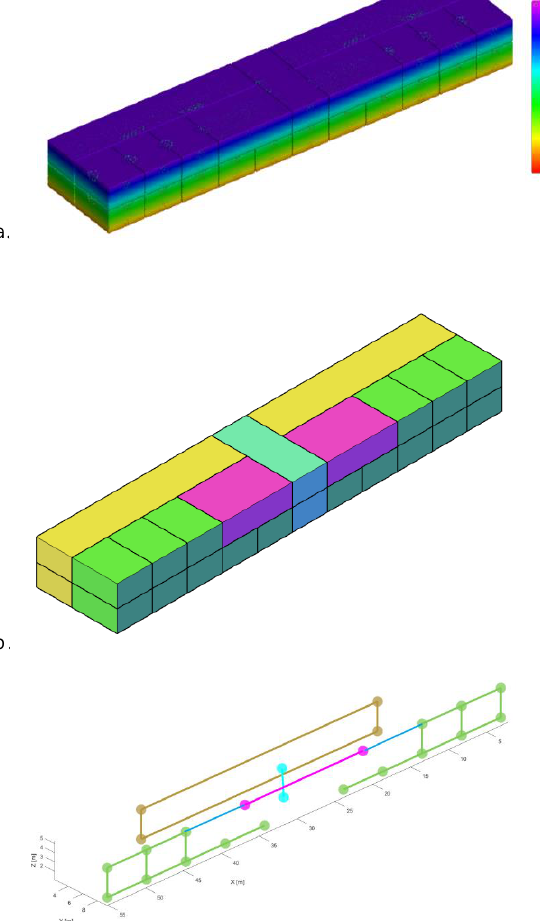
Figure 6. Estimated room hierarchy: synthetic point cloud (a); volumetric representation (b) and hierarchical representation (c) element detected as similar rooms are highlighted as spheres with the same color and same spacing constraints are represented with segments having same